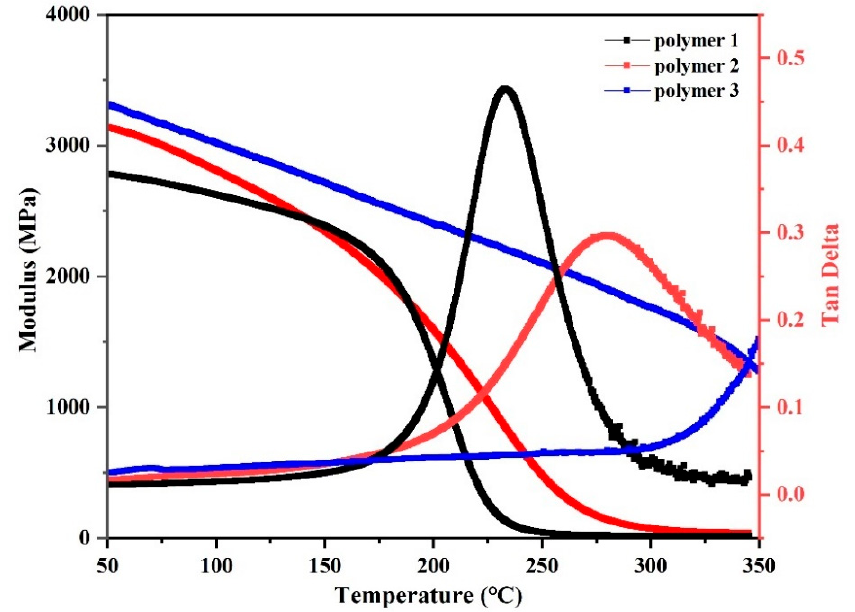
Figure 13. DMA of DPTP polymers. Table 3. Thermal–mechanical properties of the DPTP PN resin.